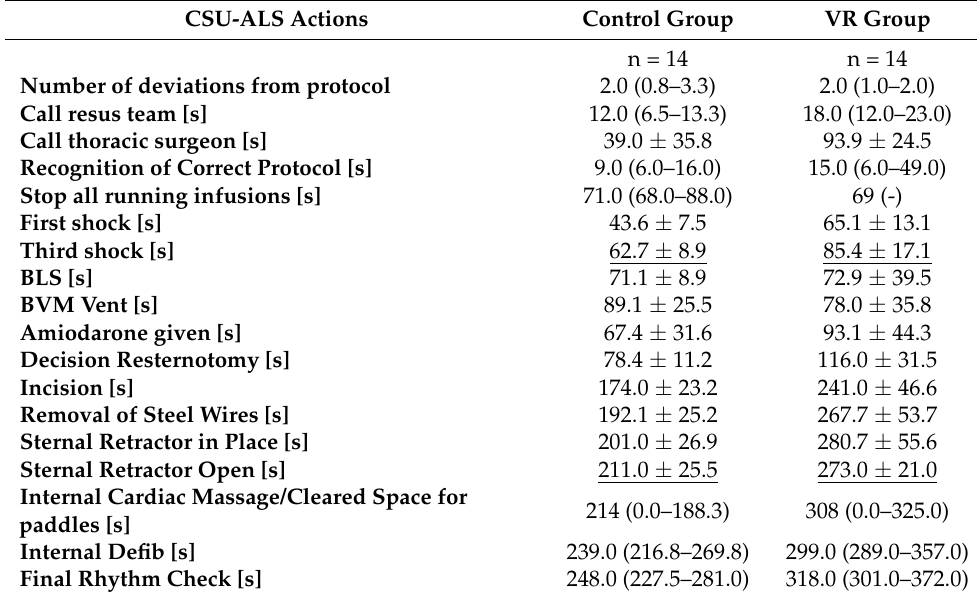
Table 3. Table shows each group’s time to defined actions in the Cardiac Surgery Unit Advanced Life Support (CSU-ALS) algorithm. Data are presented as mean ± SD or median